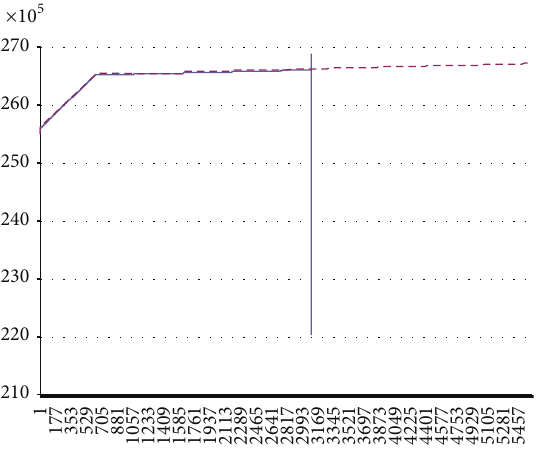
Figure 6: Flow path model of RELAP5 test.